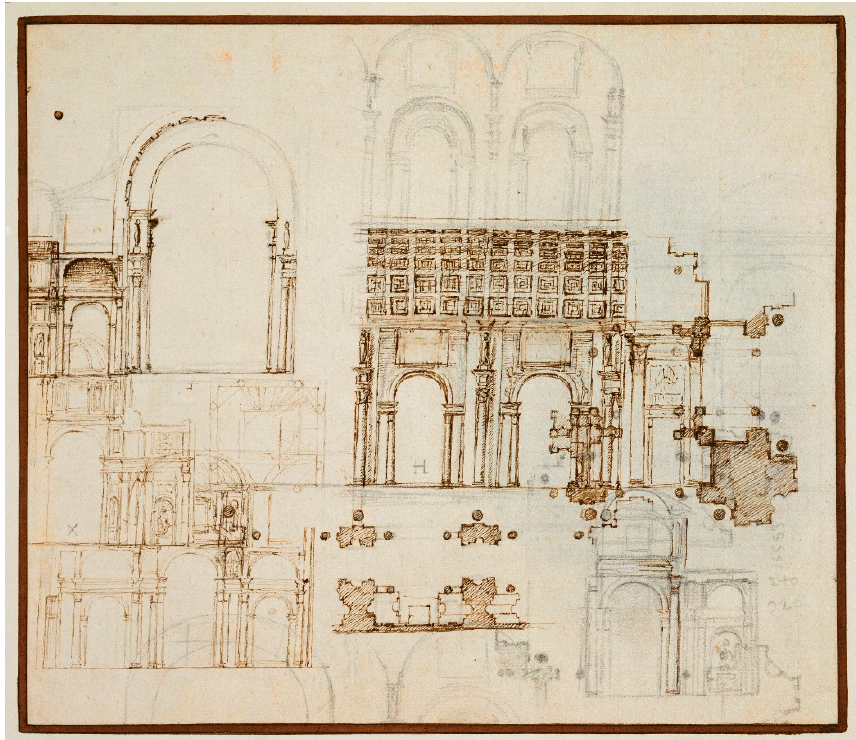
Figure 1. Domenichino, Architectural Study for St Ignatius. (RCIN 901575)—RL 01575—JPH: Pope- Hennessy, J., 1948. The Drawings of Domenichino in the Collection of His Majesty The King at Windsor Castle, London—JPH 1741. Royal Collection Trust / © Her Majesty Queen Elizabeth II 2022.